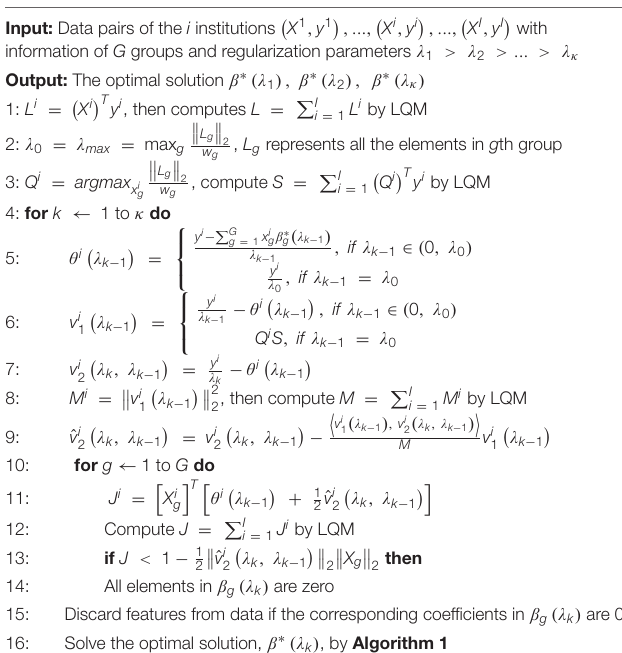
ALGORITHM 2 | Federated dual polytope projection for group LASSO